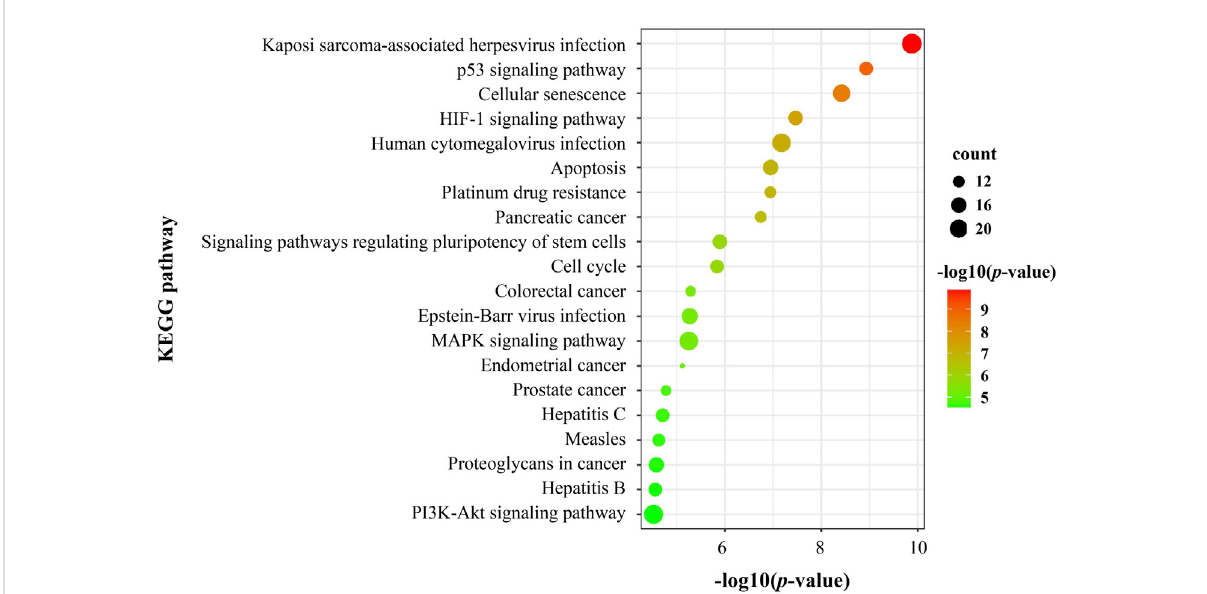
FIGURE 4 The top 20signi fi canttermsofKEGG pathway enrichment analysis of DEGs onPSCE. Abscissa: log ( p -value),ordinate: KEGGpathway.The size of the dot indicated the number of DEGs enriched in the pathway. The color indicates the signi fi cant -log ( p -value) of this pathway. The larger the -log ( p -value) was, the more signi fi cant the enrichment was.